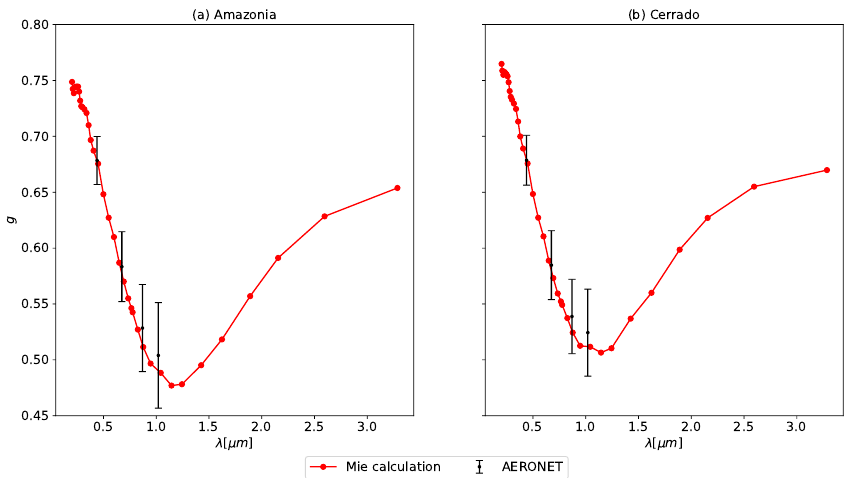
Figure A2. Asymmetry parameter obtained for the 37 spectral intervals of BRASIL-SR: ( a ) Amazonia. ( b ) Cerrado. AERONET mean values for the biomass burning period are indicated; vertical vars are the standard